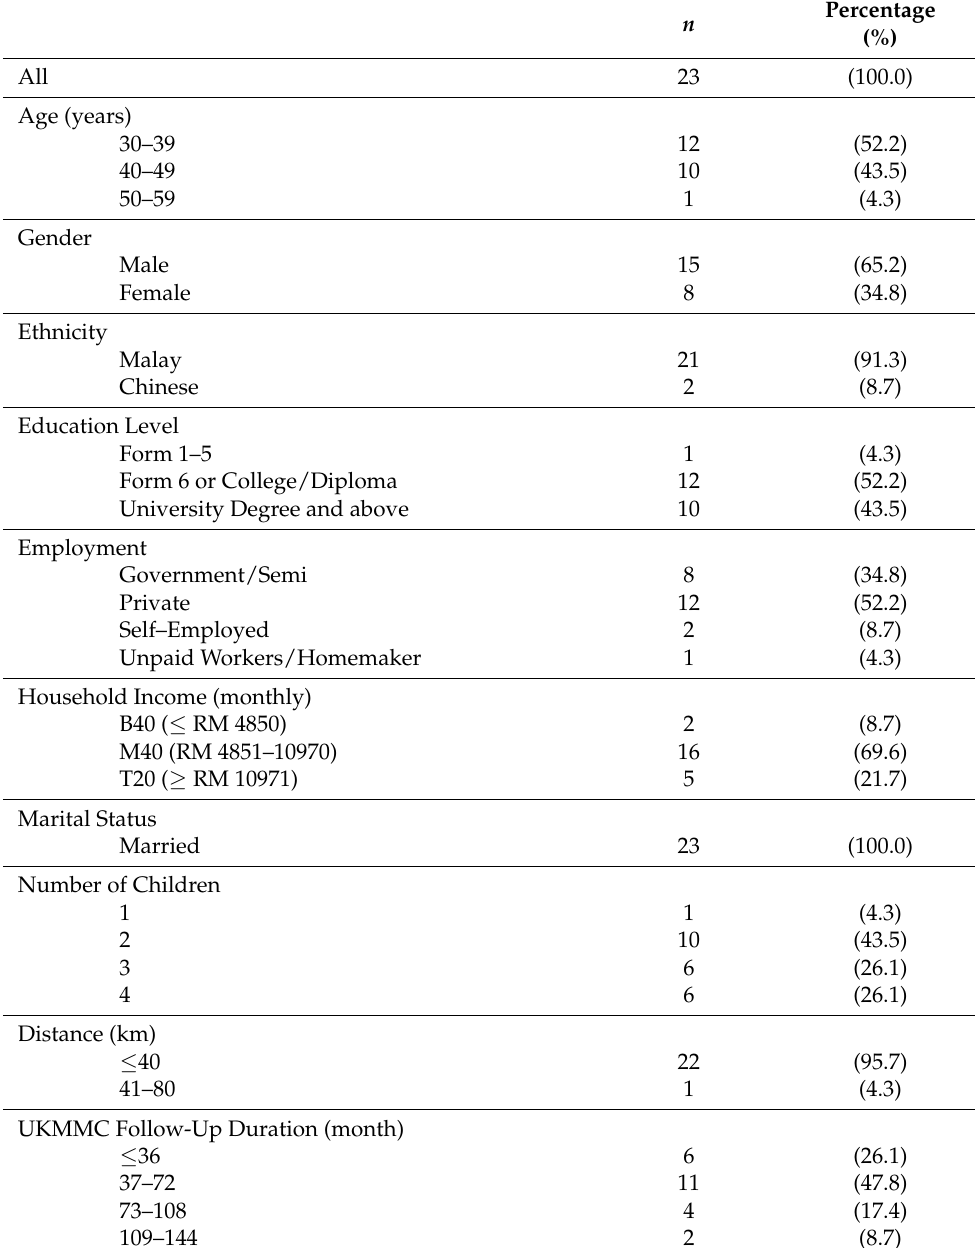
Table 8. Sociodemographic and characteristics of caregivers in Qualitative Study Phase II ( n =